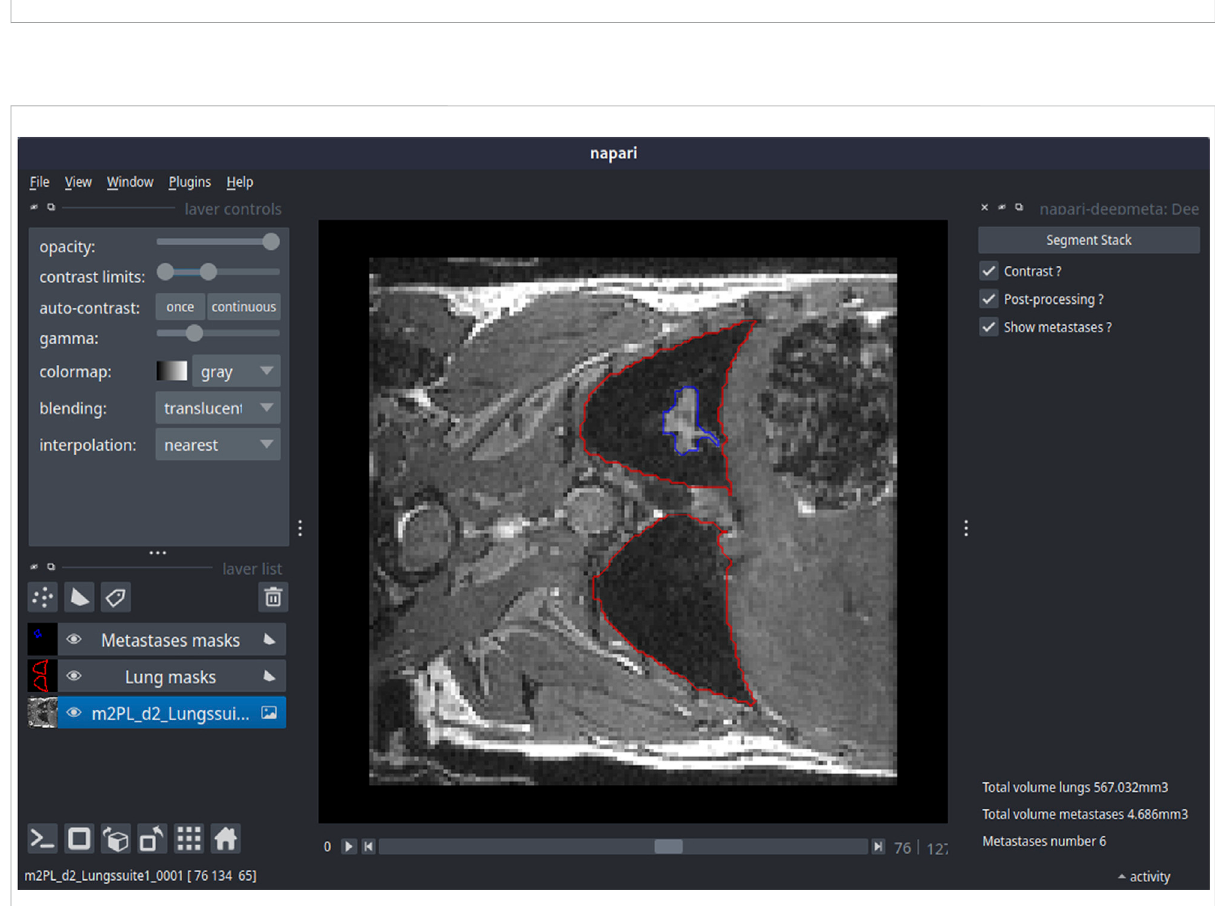
FIGURE 4 Evolutionofthevolumeandnumberofmetastasesintwomice,acontrolandanil34. (A) showstheevolutionofthetotalvolumeofmetastases per mouse over time. (B) shows the number of metastases per volume range imaged at day 25 for control LacZ and at day 120 for il34.